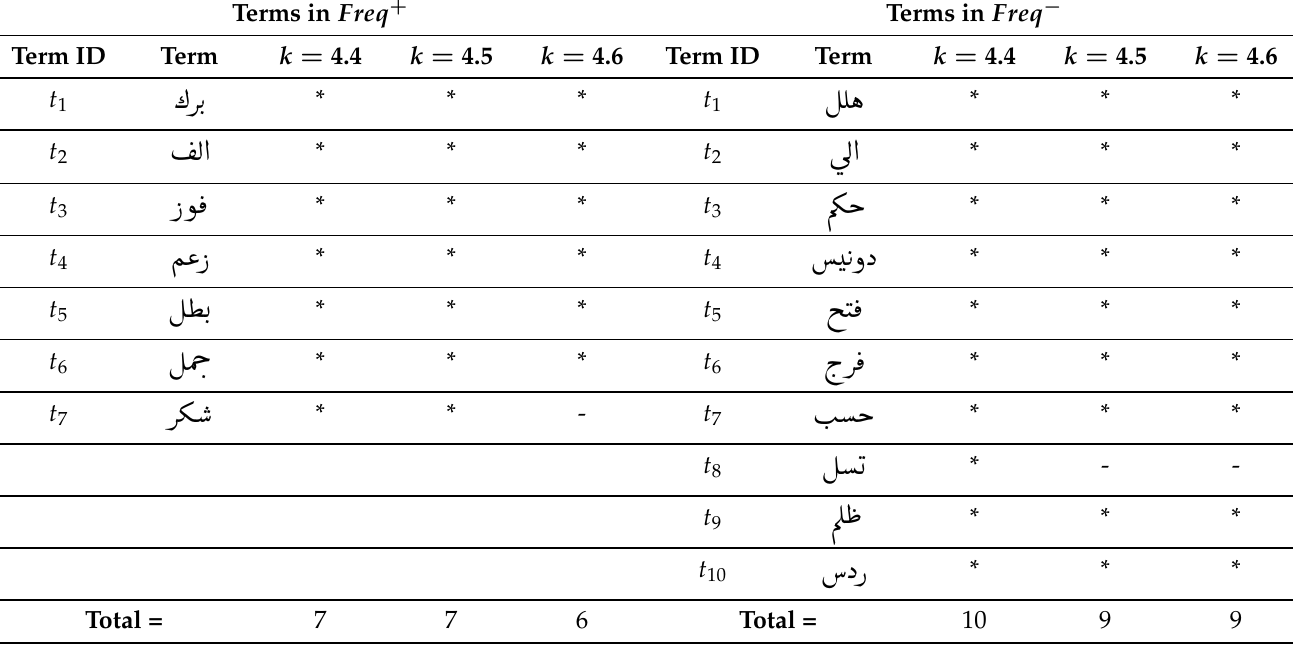
Table 13. Explanation of the reason that the same F1 score is produced with different k values.